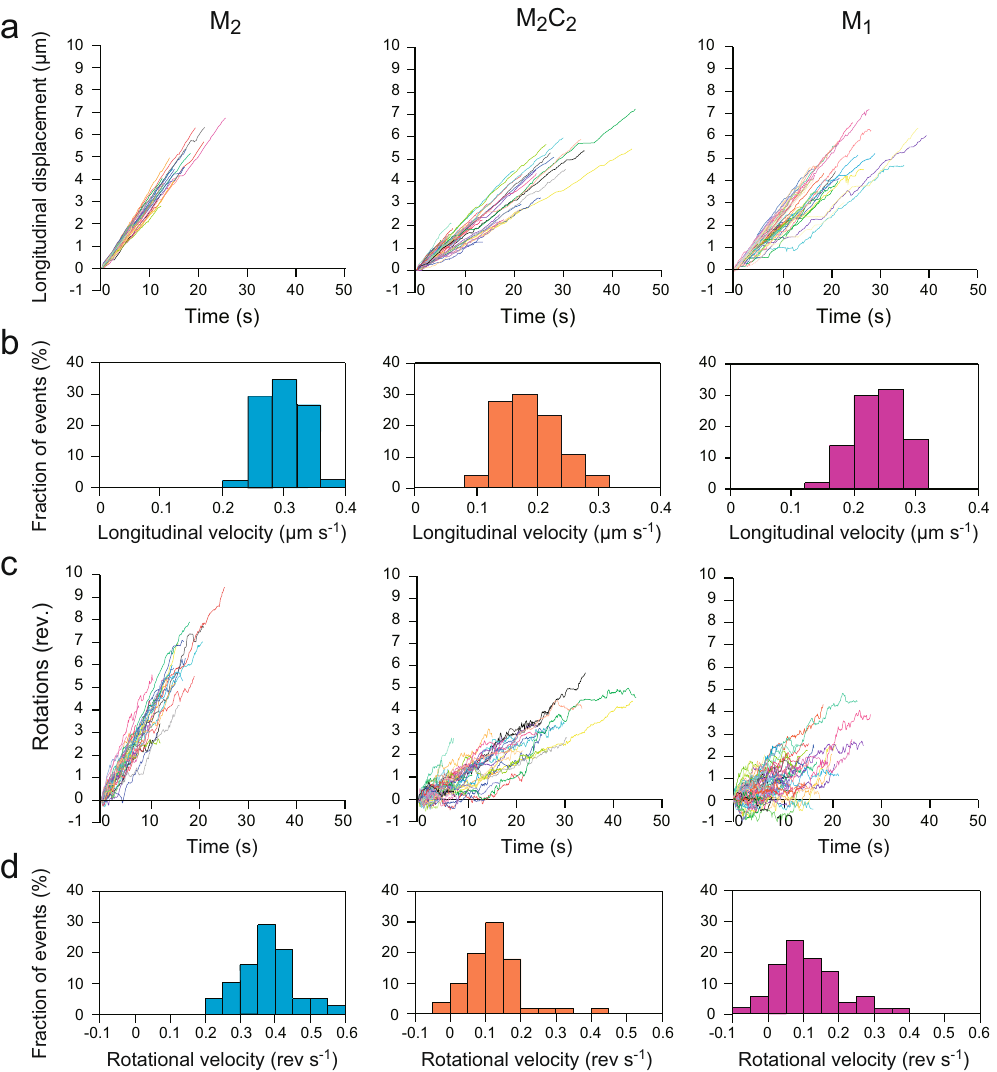
Fig. 3 Time course of longitudinal and rotational motions by MKLP1. a Time course of longitudinal distances of beads coated with M 2 ( n = 36, left), M 2 C 2 ( n = 47, middle), M 1 ( n = 47, right). b Histogram of the longitudinal velocity for M 2 (left), M 2 C 2 (middle) and M 1 (right). Individual traces in a were fi tted with linear functions to obtain the longitudinal velocity. Average longitudinal velocities, M 2 : 0.30 ± 0.03 µ m s − 1 , M 2 C 2 : 0.19 ± 0.05 µ m s − 1 , M 1 : 0.24 ± 0.04 µ m s − 1 . Data are given as mean ± standard deviation. c Time course of revolutions of beads coated with M 2 (left), M 2 C 2 (middle), M 1 (right). d Histogram of the rotational velocity for M 2 (left), M 2 C 2 (middle) and M 1 (right). Individual traces in c were fi tted with linear functions to obtain the rotational velocity. Average rotational velocities, M 2 : 0.37 ± 0.08 rev s − 1 , M 2 C 2 : 0.12 ± 0.05 rev s − 1 , M 1 : 0.11 ± 0.09 rev s − 1 . Data are given as mean ±